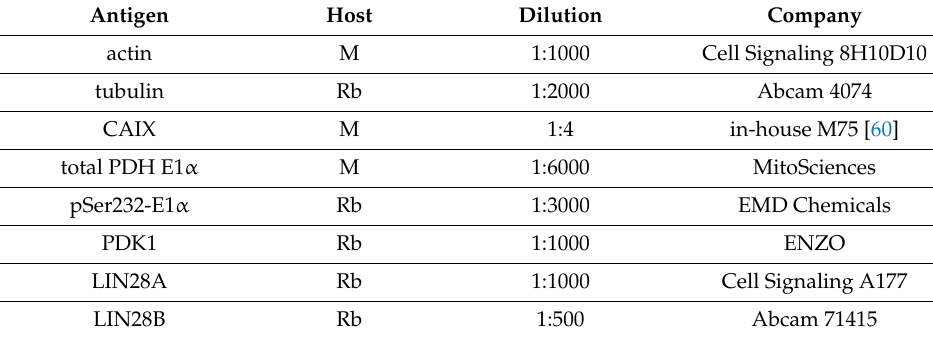
Table 2. List of primary antibodies.